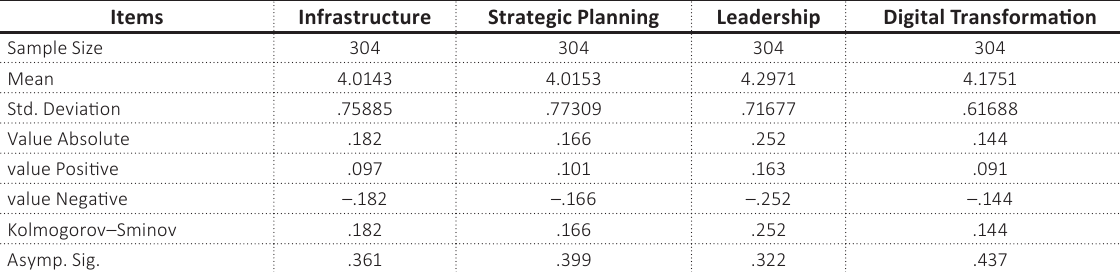
Table 3. Normal distribution of dependent variable dimensions